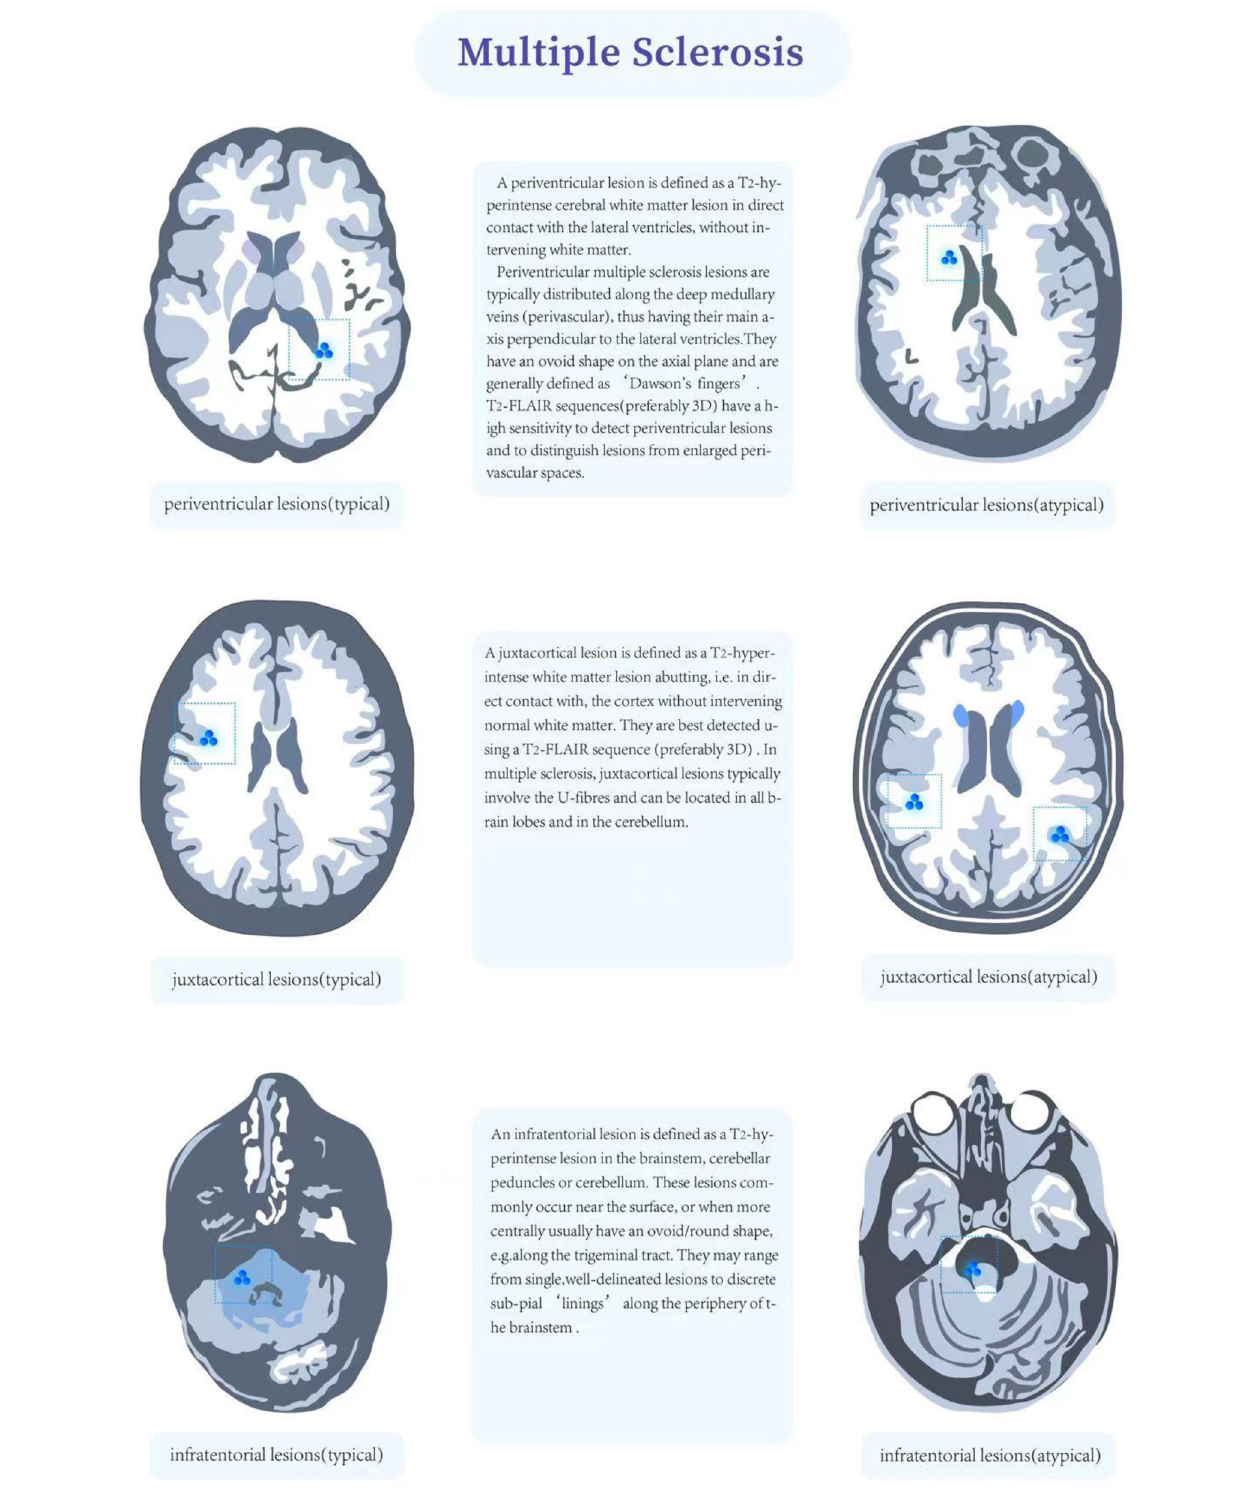
FIGURE 2 | Charateristics of multiple sclerosis lesion that that are typical (right) and atypical (left) .